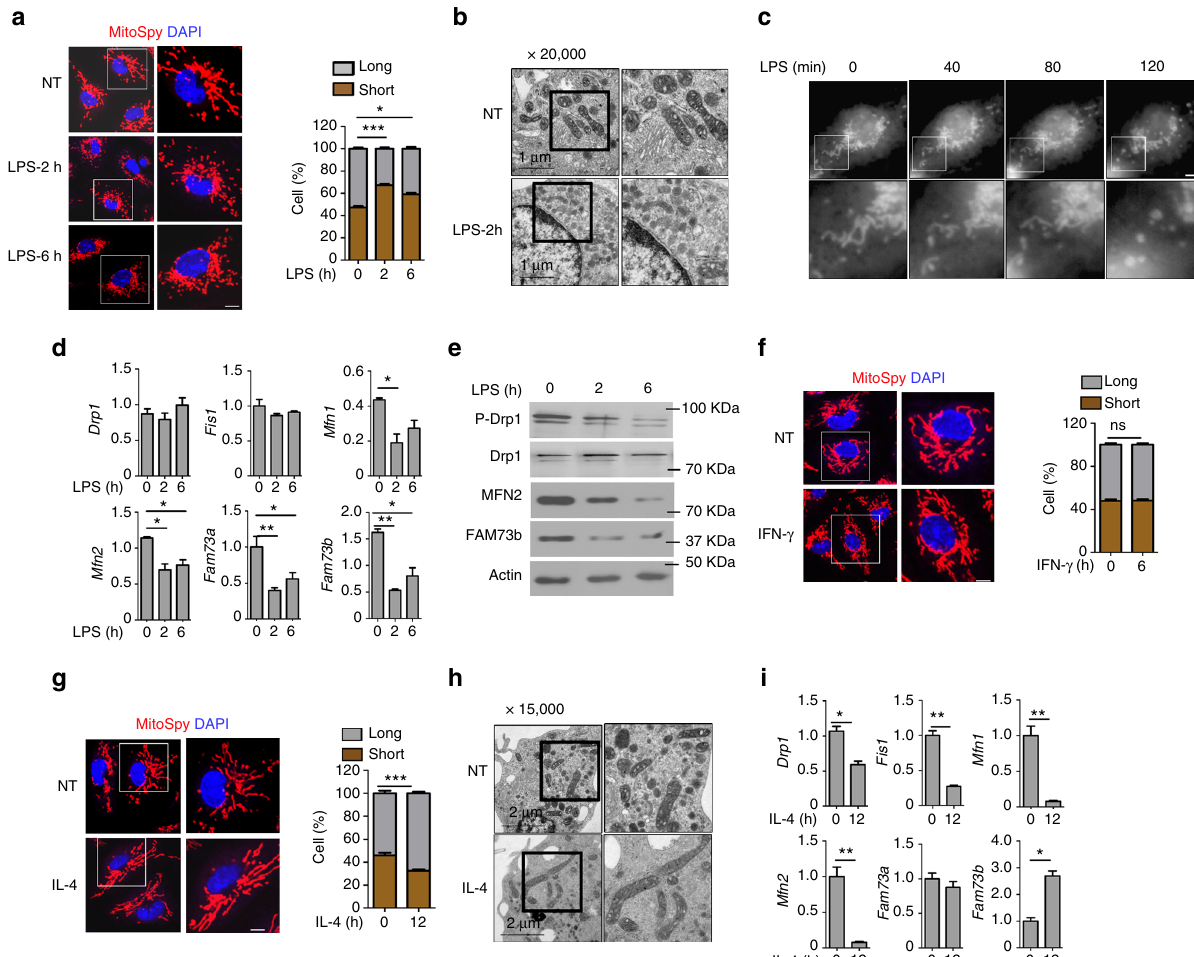
Fig. 1 FAM73b controls mitochondrial morphology. Primary BMDMs treated with LPS (500 ng/ml) at the indicated time points. Mitochondria were visualized using MitoSpyTM Orange CMTMRos staining. Representative confocal images of the mitochondrial morphology are shown, and quanti fi cation was analyzed with Image-Pro and presented as a bar graph ( a ). The data are shown as the mean ± SEM of three independent experiments, with 100 cells counted for each replicate; colors indicate the mitochondrial morphology (long or short). b The mitochondrial morphology of WT BMDMs was analyzed with EM (scale bar, 1 μ m). c Time-lapse images of WT BMDMs treated with LPS (500 ng/ml) and stained with MitoSpyTM Orange CMTMRos. d , e qRT- PCR and IB analyses of the indicated genes using LPS-stimulated BMDMs from WT mice. f Representative confocal images and bar graph of WT BMDMs stimulated with IFN- γ (10 ng/ml) for 12 h. ( g , h ) WT BMDMs stimulated with IL-4 (20 ng/ml) for 12 h. Representative confocal ( g ) and EM ( h ) images are presented. i The indicated genes were measured with qRT-PCR. All qRT-PCR data are presented as fold-induction relative to the Actb mRNA level. All the data are representative of three independent experiments. Scale bars in a , c , f and g are 5 μ m; one in b is 1 μ m; one in h is 2 μ m. Error bars are the mean ± SEM values. Two-tailed unpaired t -tests were performed. * P < 0.05; ** P <